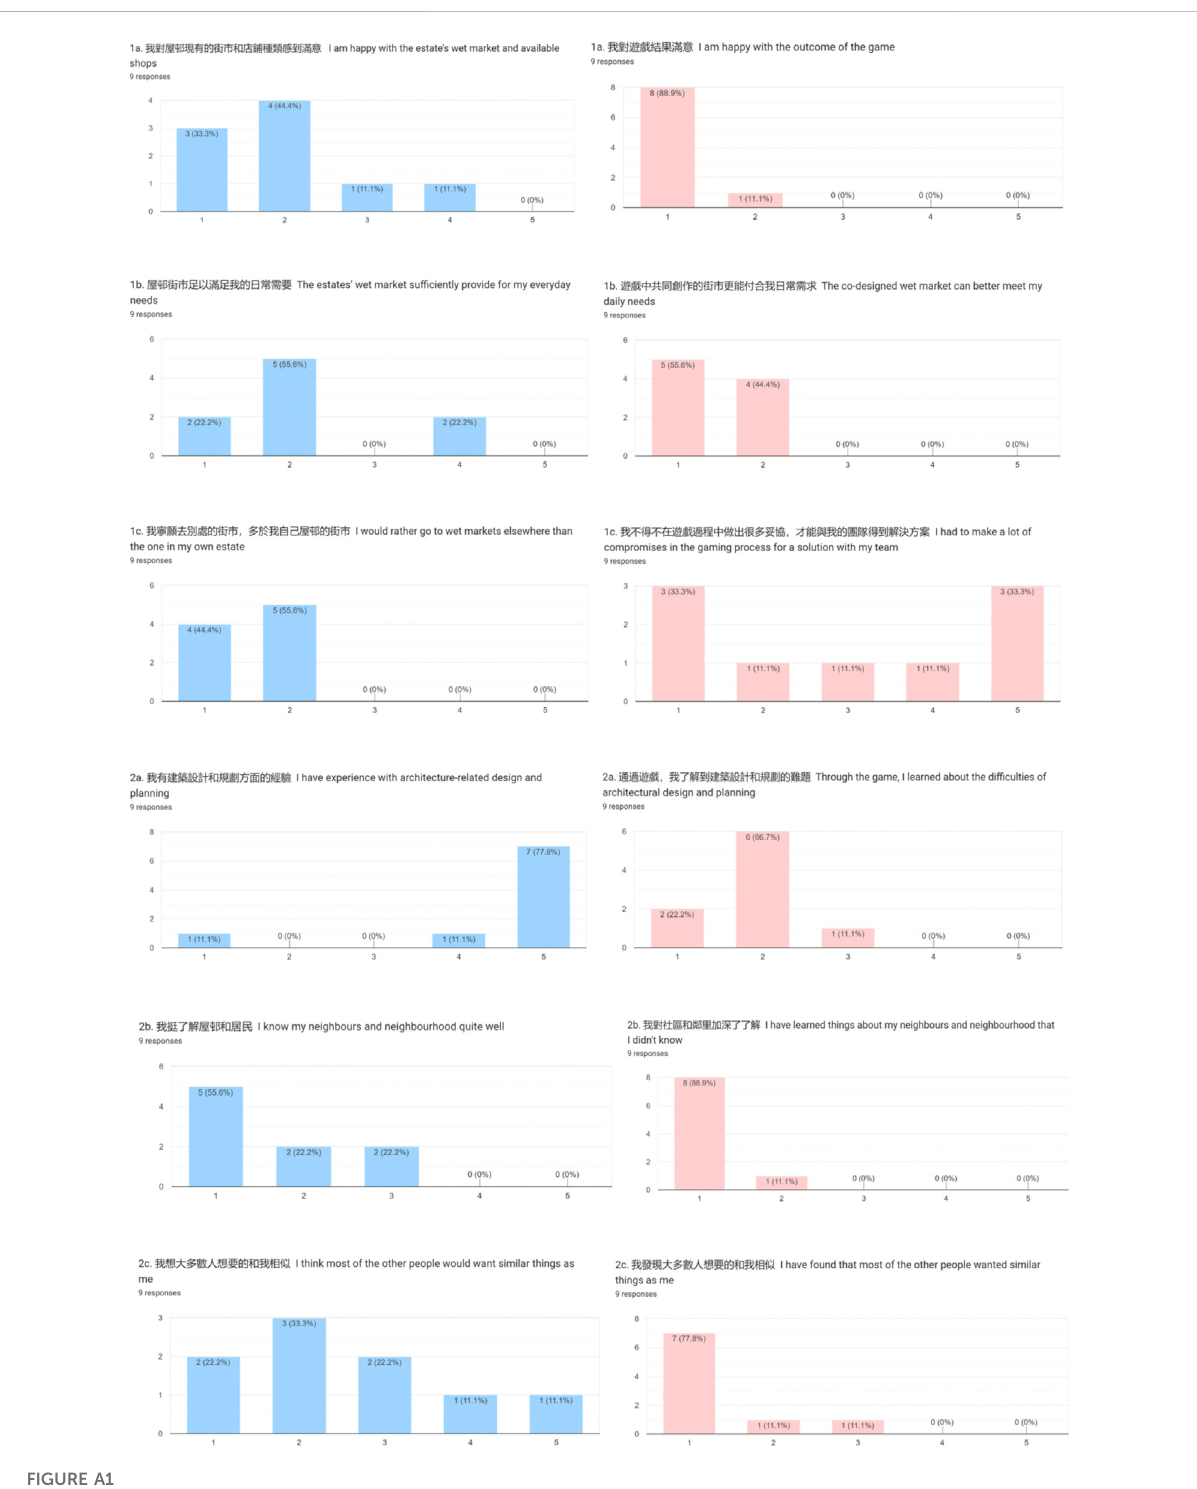
FIGURE A1 Pre-gameplay (blue) and post-gameplay (pink)